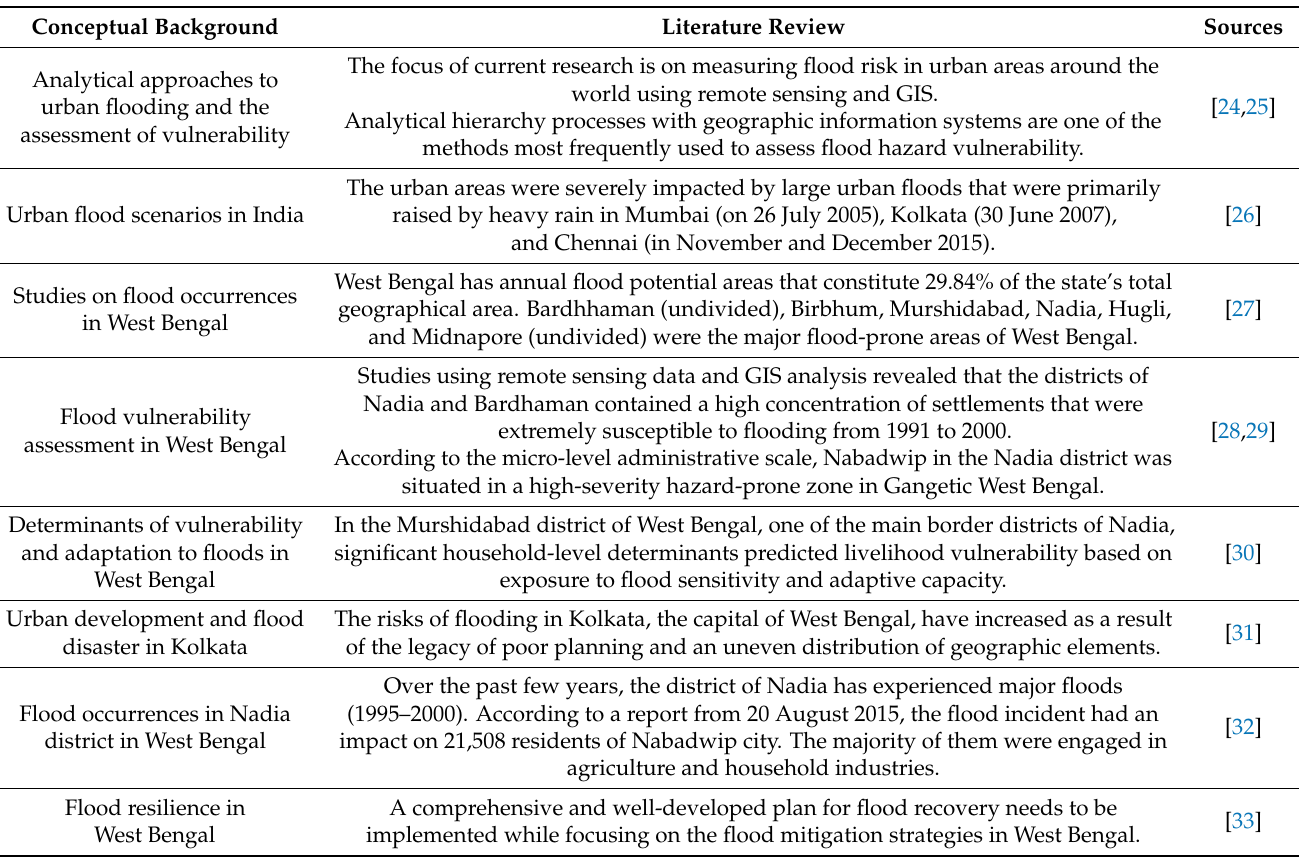
Table 1. Literature regarding the conceptual background of the